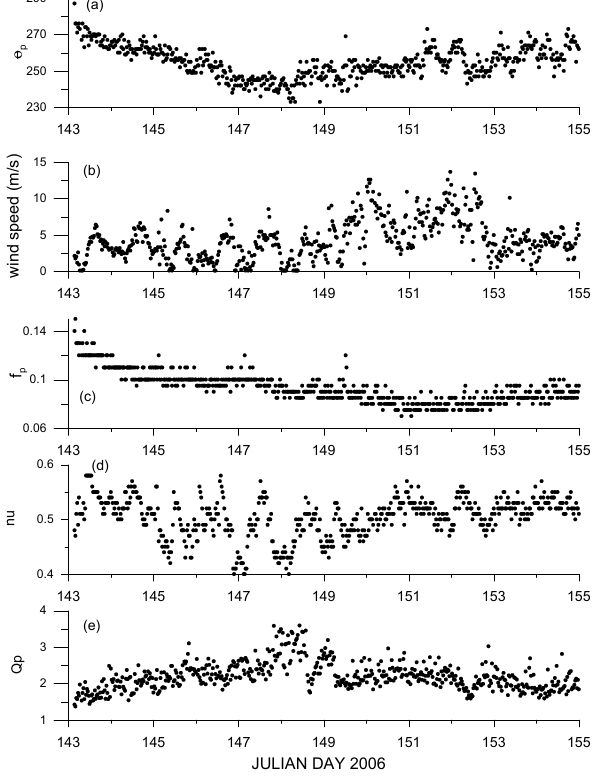
Figure 5. Variation of (A) peak wave direction, (B) wind speed, (C) peak frequency, (D) Fig. 5. Variation of (a) peak wave direction, (b) wind speed, spectral narrowness parameter and (E)spectral peakedness parameter (c) peak frequency, (d) spectral narrowness parameter and (e) spec- tral peakedness